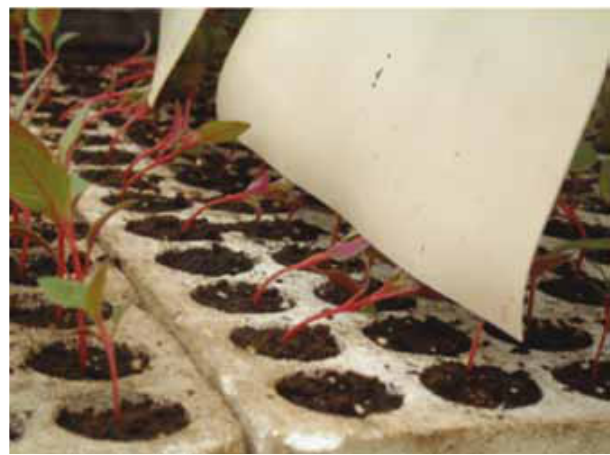
Figure 16: Technical innovation – seedling with growth reducing machine